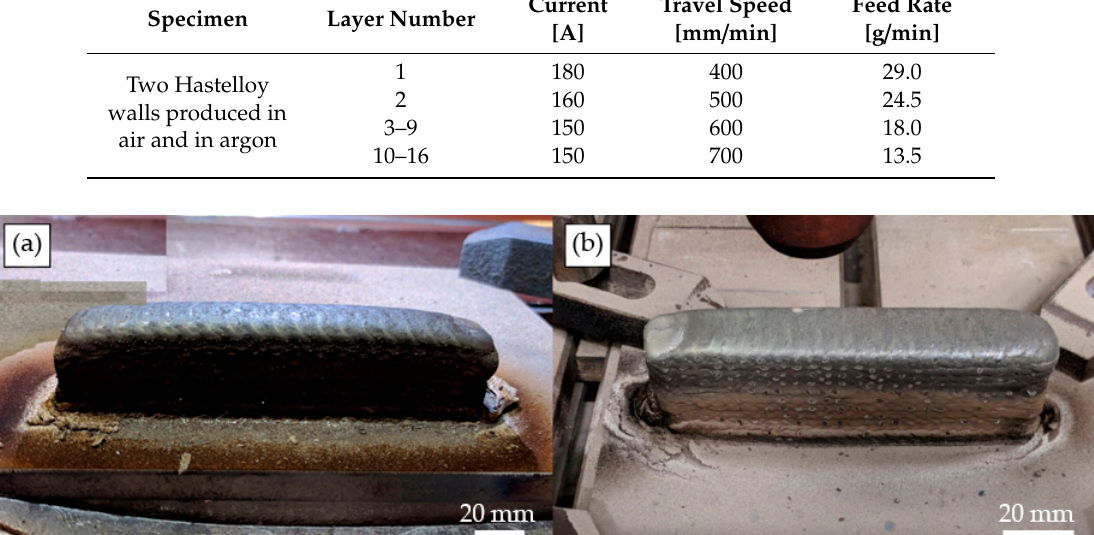
Figure 6. Walls in as-built conditions: ( a ) Produced under air atmosphere, ( b ) produced under argon atmosphere. Table 3. Fabrication parameters for Hastelloy C-22 wall produced in air and in argon atmosphere.